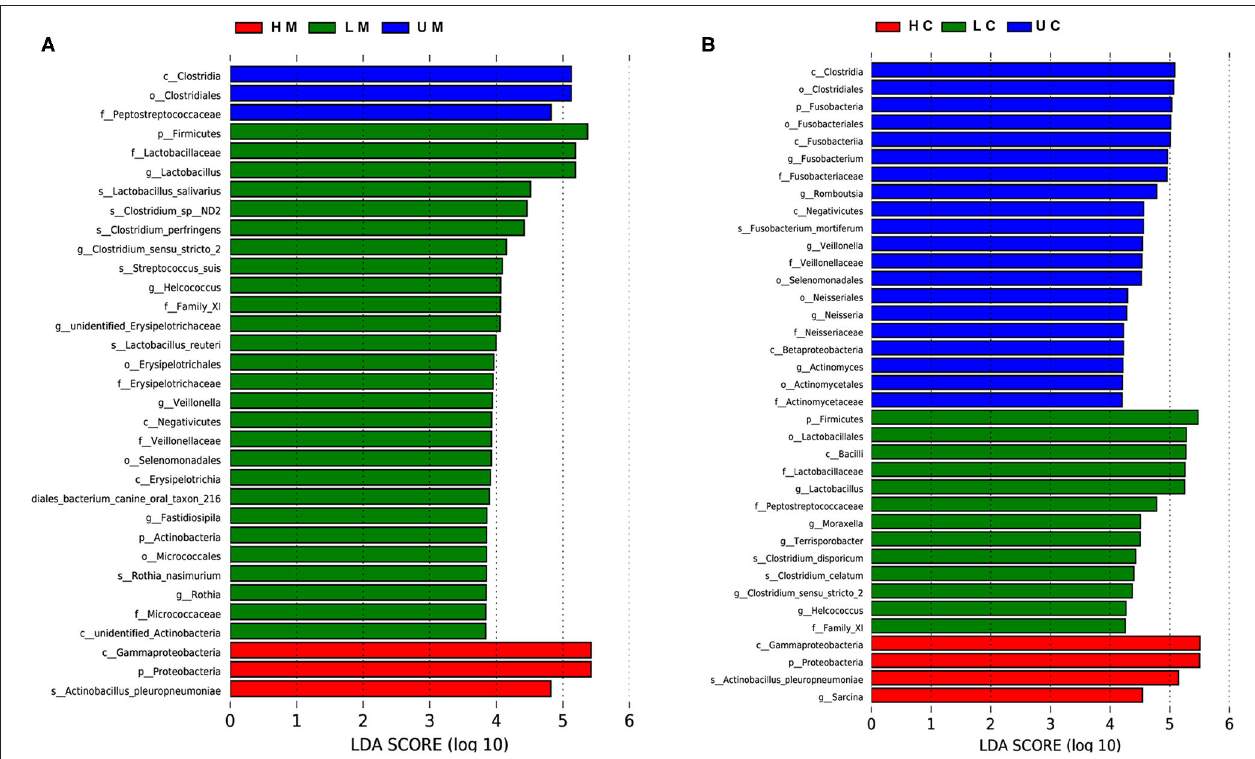
FIGURE 4 | Linear discriminant analysis (LDA) effect size (LEfSe) of jejunal mucosa and content microbiome samples from the uninfected, low viral load, and high viral load groups. Histogram of LDA scores computed for differences in the proportions of bacteria at different taxonomic levels in jejunal mucosa (A) and jejunal content (B) samples between uninfected, low viral load, and high viral load groups.